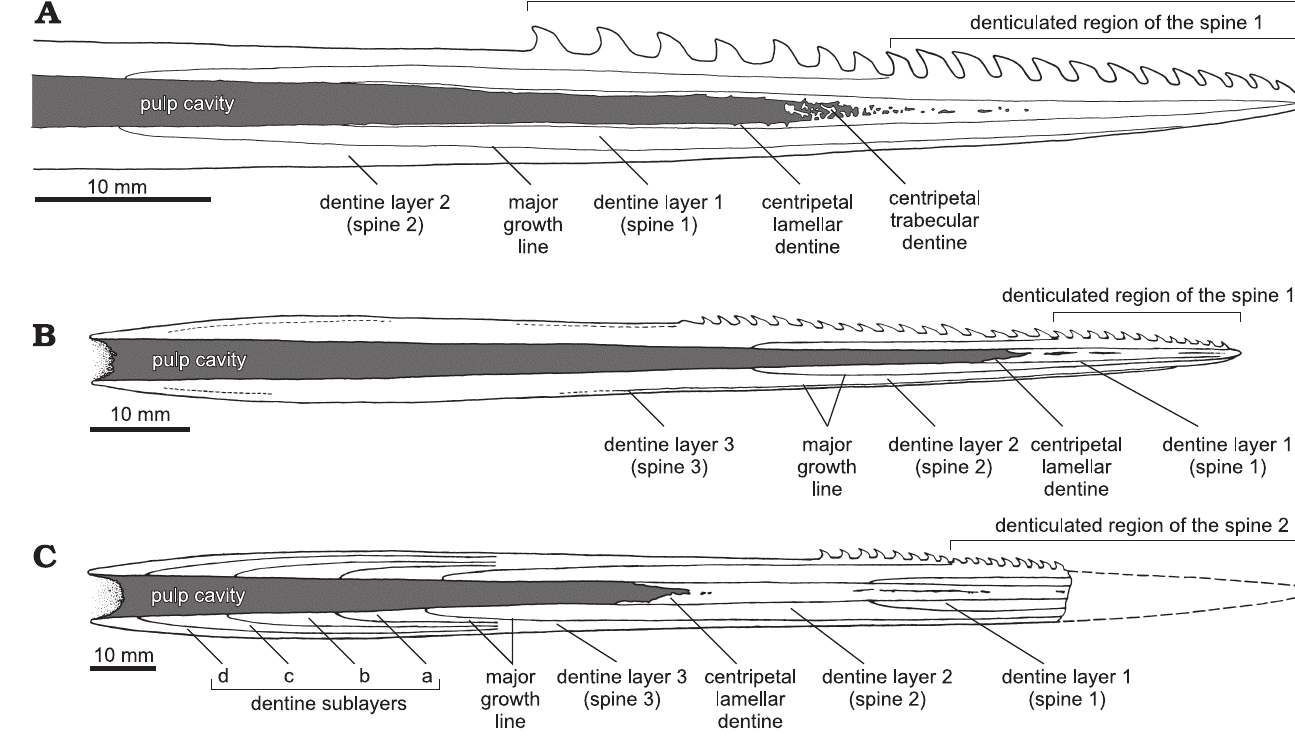
Fig. 8. A . Reconstruction of the dorsal spine (mainly the denticulated region) of Orthacanthus platypternus , based on specimens HMNS-T1 and HMNS-T2. B , C . Reconstructions of the dorsal spine of Orthacanthus meridionalis (modified from Soler-Gijón 1999: fig. 10); PU-XE76 ( B ) PU-XE19 ( C ). Note that distal denticles belong to the first spine (juvenile). The intersection of the first major growth line and the denticulated border of the spine indicate the prox- imal end of the denticulated region of the first spine; the following “spines” exhibit the distal denticles and those corresponding to each new growth